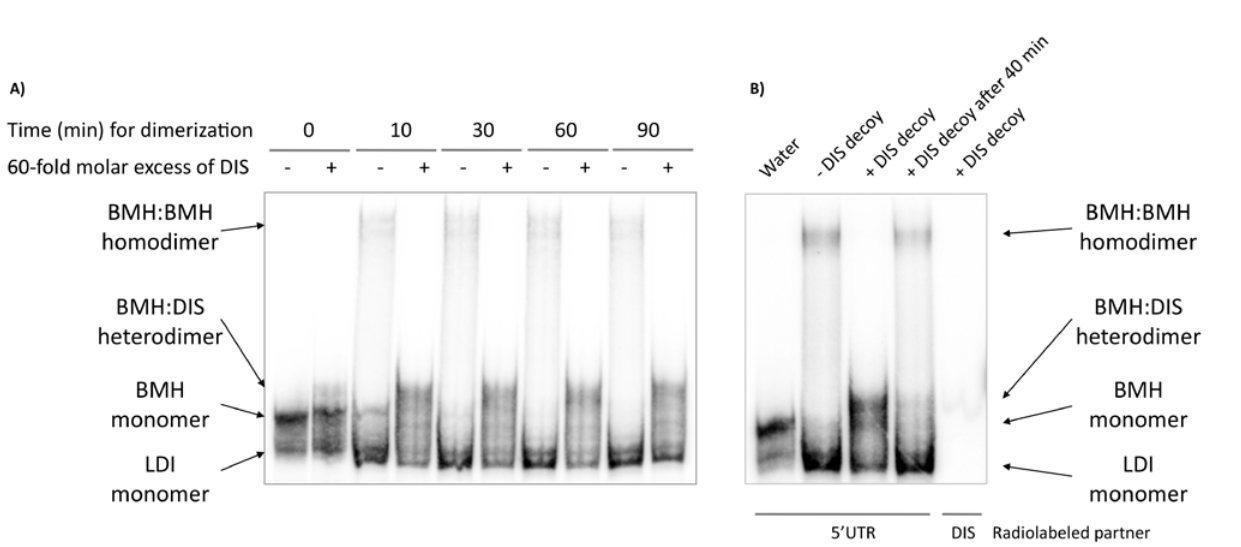
Figure 6. Involvement of the different 5’UTR conformers in the RNA dimerization process. ( A ) Autoradiogram of a polyacrylamide gel electrophoresis of a 5’ UTR dimerization reaction time course. Dimerization reactions were performed as described in the experimental section. Different molecular species are identified at the left side of the gel. ( B ) The thermodynamic relationship between 5’UTR RNA isoforms. Line 1 (water): 5’UTR was denatured and renatured in water. Line 2 (–DIS decoy): 5’UTR was denatured and renatured in water, and incubated for 40 min at 37 ºC in 1X dimer buffer. Line 3 ( + DIS decoy): the same procedure as line 2, but a 60-fold molar excess of unlabelled DIS decoy was added at time 0. Line 4 ( + DIS decoy after 40 min): the same procedure as line 2 but a 60-fold molar excess of unlabelled DIS decoy was added after 40 min incubation in dimerization conditions; the reactions were followed for another additional 40 min at 37 ºC. Line 5 (+DIS decoy): the same procedure as line 2, but the DIS decoy was internally radiolabelled and 5’UTR unlabelled. Different molecular species are identified by a schematic representation depicted on the right side of the